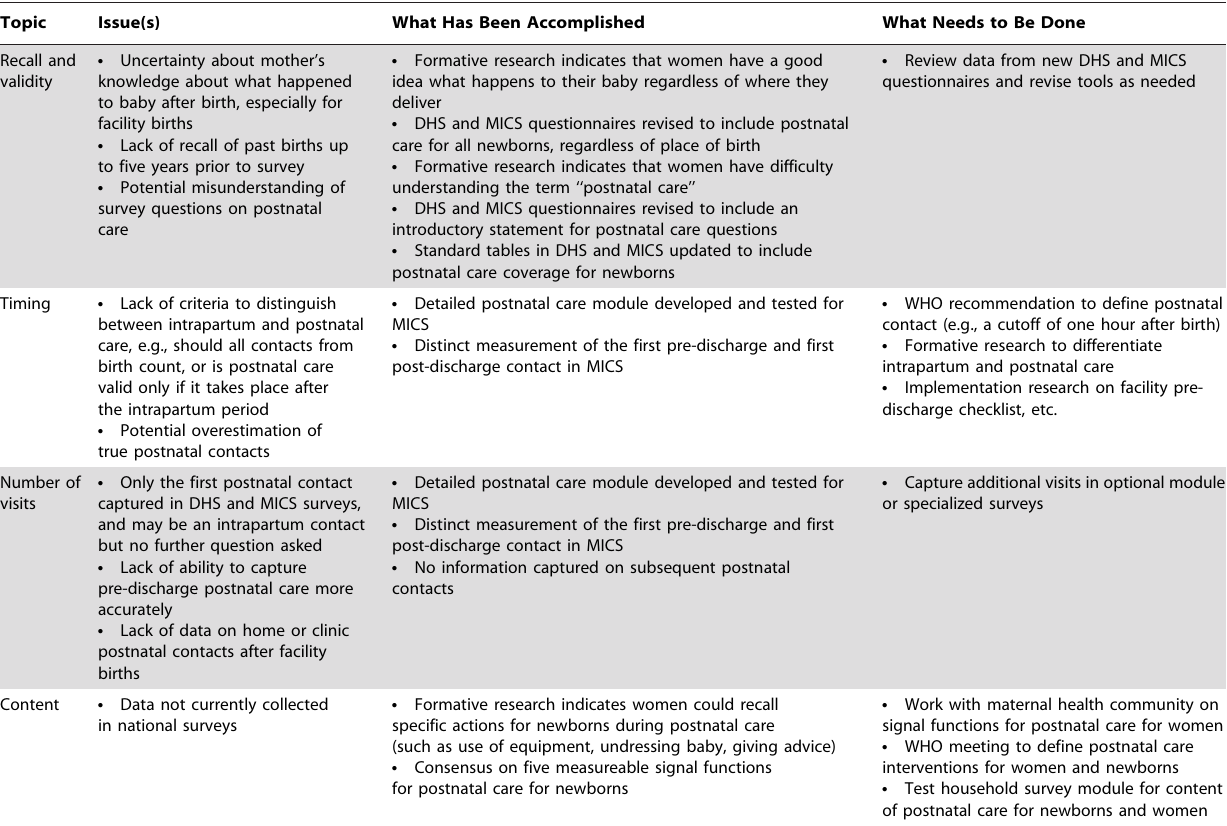
Table 1. Postnatal care indicator: measurement issues and advances.